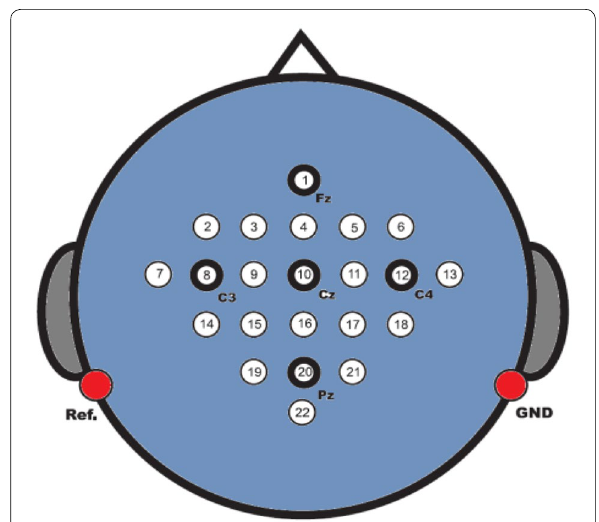
Fig. 2 The channel number and their locations on the scalp of the used EEG